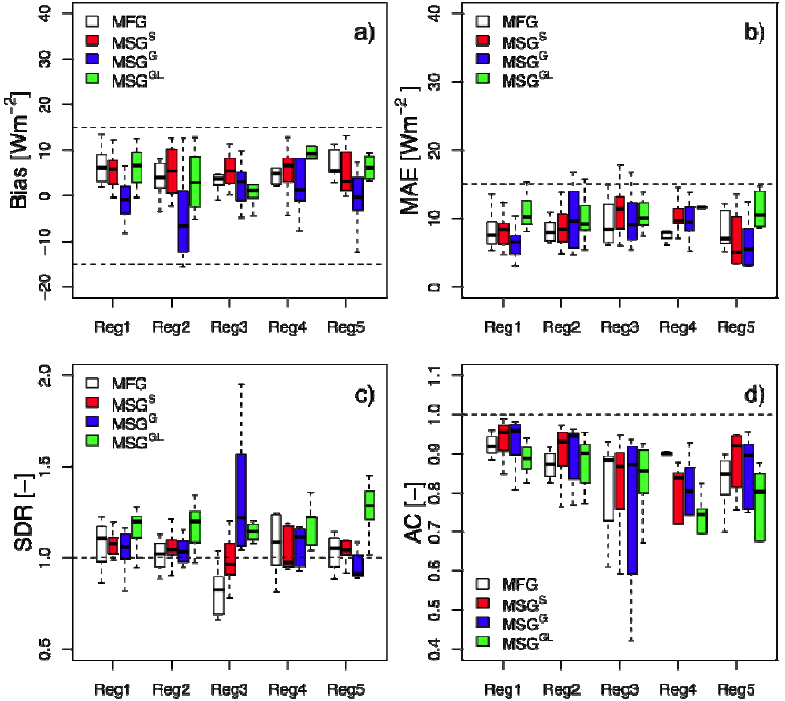
Figure 3. Comparison of monthly SIS between CM SAF and GEBA measurements for MFG and MSG satellites, for five regions (see Figure 1). ( a ) Mean bias [W·m − 2 ], ( b ) MAE [W·m − 2 ], ( c ) anomaly standard deviation ration (SDR) [1], and ( d ) anomaly